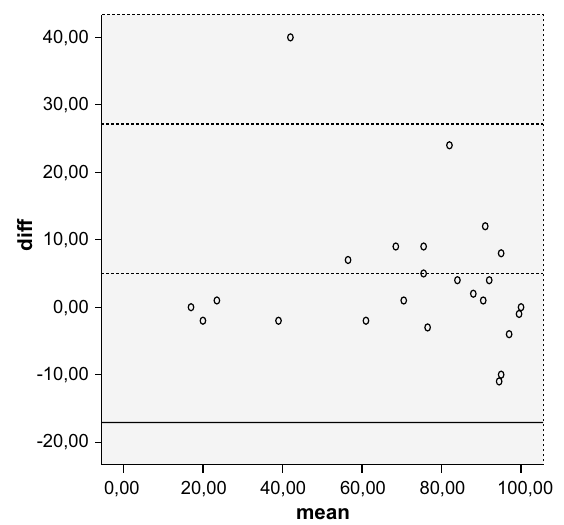
Fig. 4 Bland–Altman plot showing test–retest results for 33 patients completing the Italian version of the Fulkerson index. The dashed line shows the mean difference; solid lines show the 95 % confidence interval